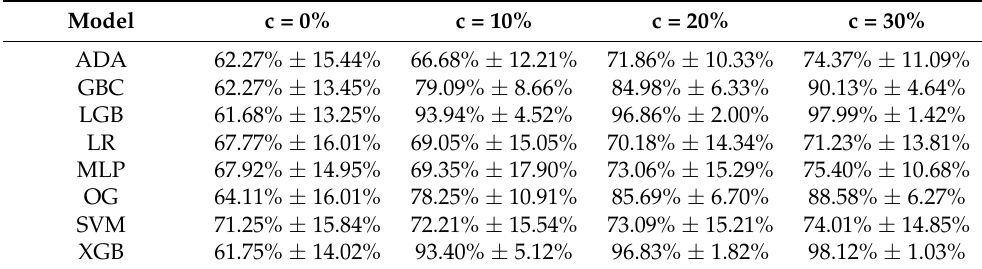
Table 5. Combined mean accuracy and standard deviations of the tested models for classifying positions as left-side lying, supine, or right-side lying.